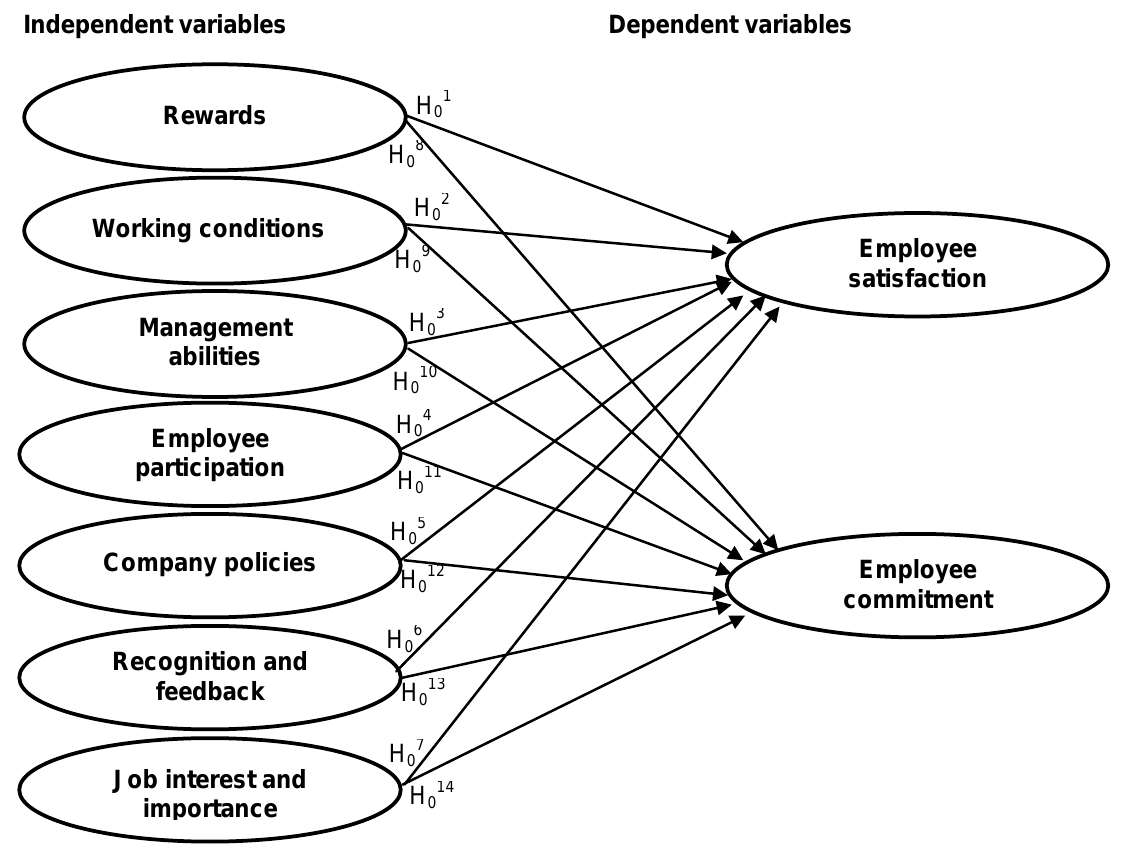
Figure 1: Seven motivational factors which may influence employee satisfaction and commitment Independent variables Dependent